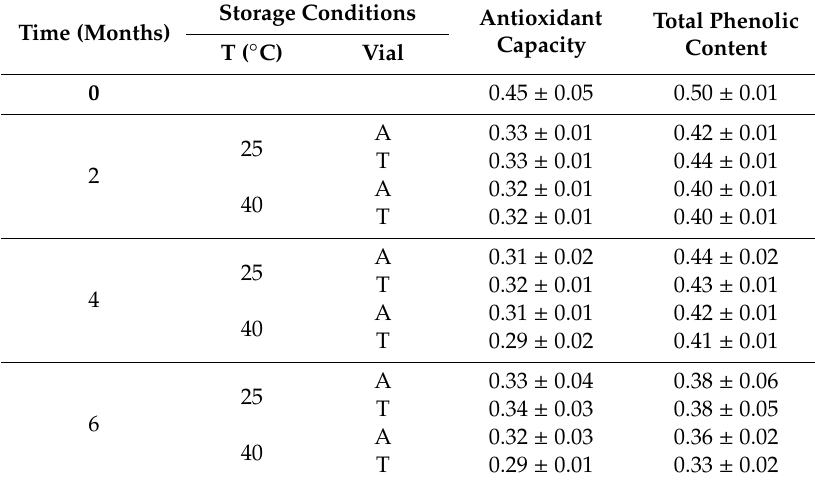
Table 1. Antioxidant capacity (mmol Trolox / g grape stem extract) and total phenolic content (mmol gallic acid / g grape stem extract) of grape stem extracts during storage at di ff erent conditions of temperature and light (T: transparent vial, A: amber